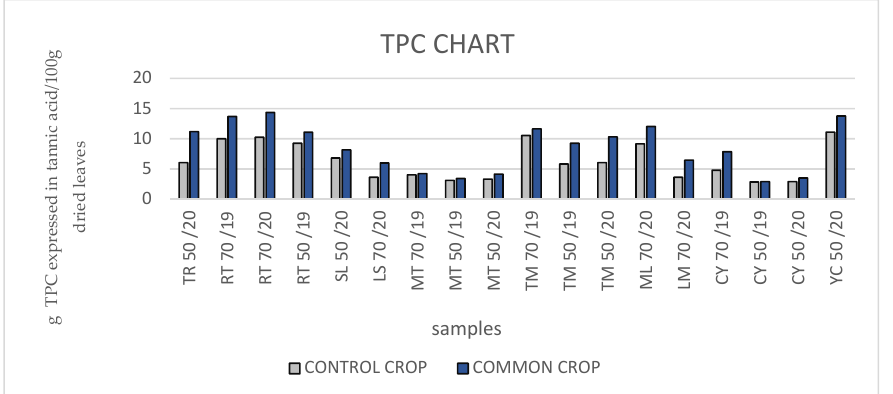
Figure 18. Graphic representation of total PACs (phenolcarboxylic acids) content.